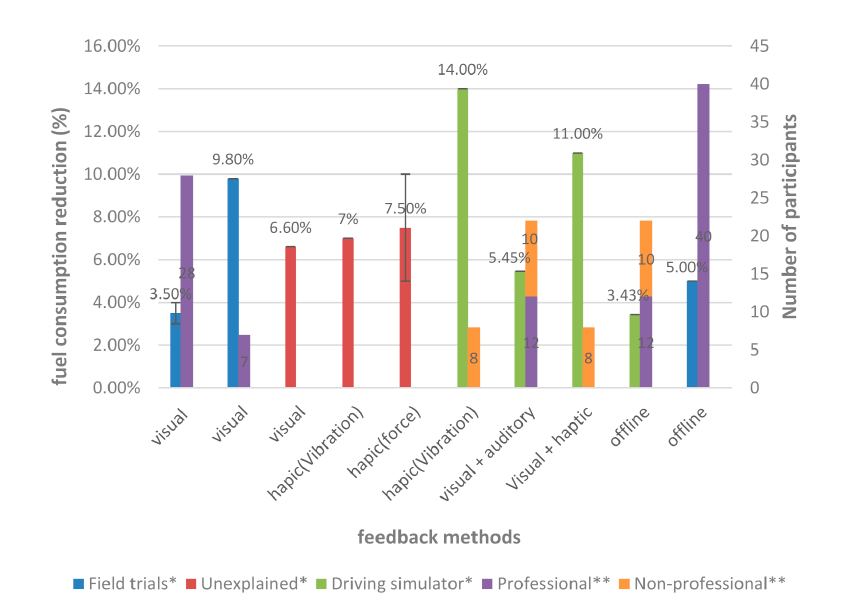
Figure 6. The effect of feedback method and test scale on energy saving. Data acquisition methods are divided into three categories, among which “Unexplained” represents that the acquisition method is not given in the study. Error bars represent the maximum and minimum values. Symbols for this figure: * fuel consumption reduction, ** number of participants. If the bar is not shown it means it is not stated in the study. economic incentives: